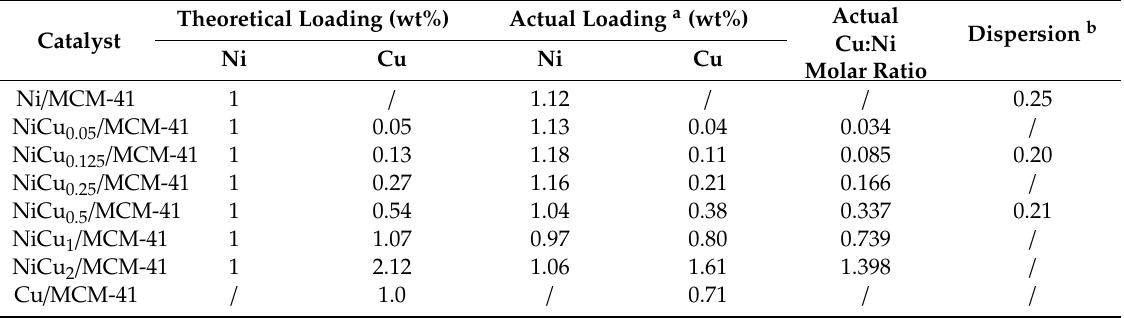
Table 1. Metal loadings and Cu to Ni molar ratios of the NiCu x /MCM-41 catalysts and other parameter. Theoretical Loading (wt%) Catalyst